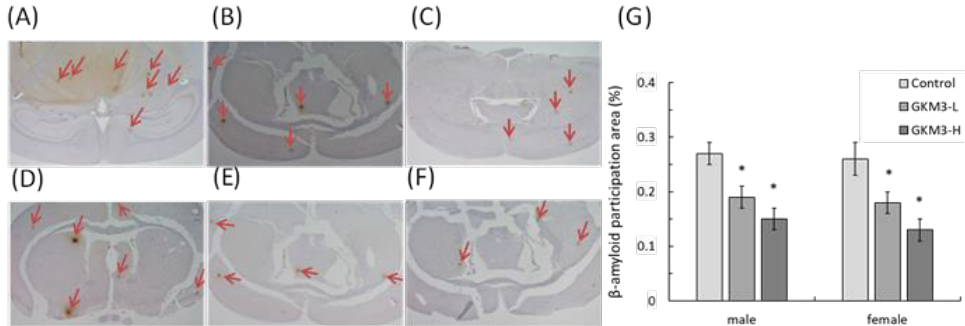
Figure 5. The β -amyloid participation in SAMP8 mice brains (40X) after 14 weeks of probiotic GKM3 consumption. ( A ): control male; ( B ): GKM3 low-dose male; ( C ): GKM3 high-dose male; ( D ): control female; ( E ): GKM3 low-dose female; ( F ): GKM3 high-dose female; and ( G ): the percentage of the amyloid- β participation area. The arrows point to the participation of amyloid- β. Values are presented as mean ± S.E.M. (n = 5). * p < 0.05 was regarded as a significant difference (one-way ANOVA).